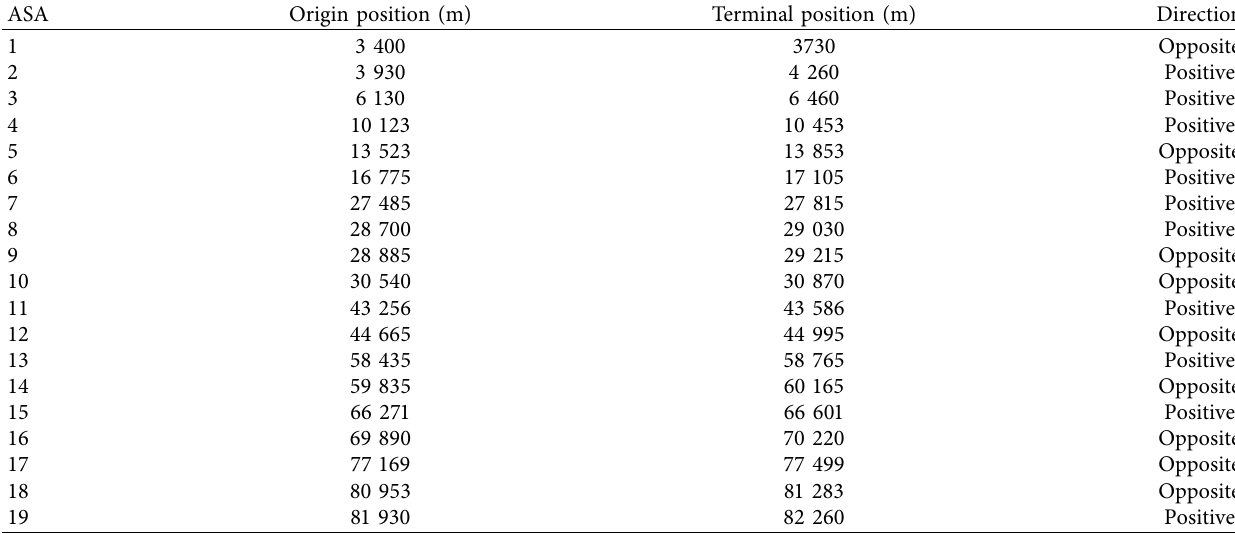
Table 2: ASA positions considering the two directions separately.